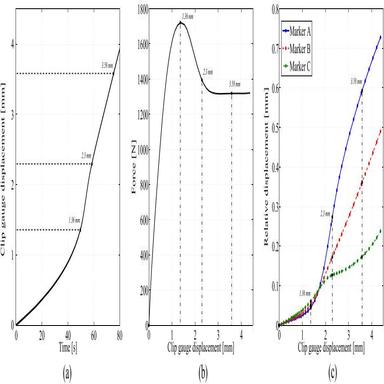
Experimental results of (a) clip-gauge displacement, (b) force, and (c) relative transversal displacements of markers.